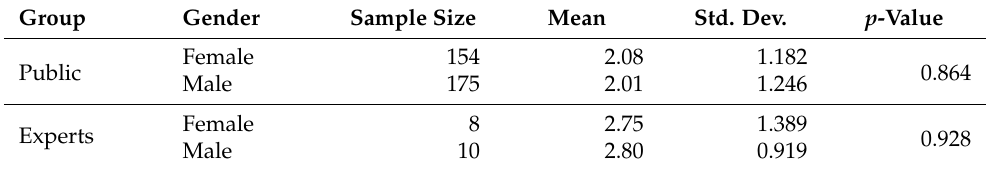
Table 10. Willingness to install a wind turbine in one’s own garden, grouped by gender. Group